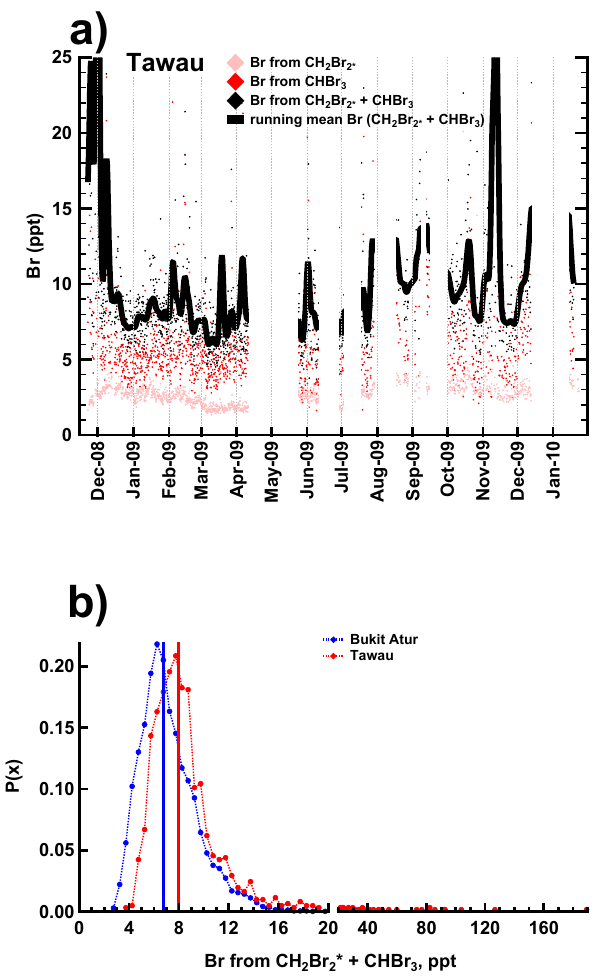
Figure 8. Estimated total Br (a) from observed CHBr 3 and CH 2 Br ∗ 2 as a time series at Tawau and (b) as probability distribution func- tions at Bukit Atur and Tawau. Bromine from CH 2 Br ∗ is shown by 2 the light-red dots (a) and from CHBr 3 by the dark-red dots, whilst Br summed from CHBr 3 and CH 2 Br ∗ is shown by the black dots 2 and the heavily smoothed black line respectively. The probability distributions for Bukit Atur (blue circles with blue dotted line) and Tawau (red circles with red dotted line) for the 10-month period from November 2008 to August 2009 are similar (b) . The total Br median values shown as blue (Bukit Atur) and red (Tawau) vertical lines agree with each other to within 1.2ppt. Occasionally very high total Br observed at Tawau is clearly seen (right of the x axis break); events higher than 20ppt were never observed at Bukit